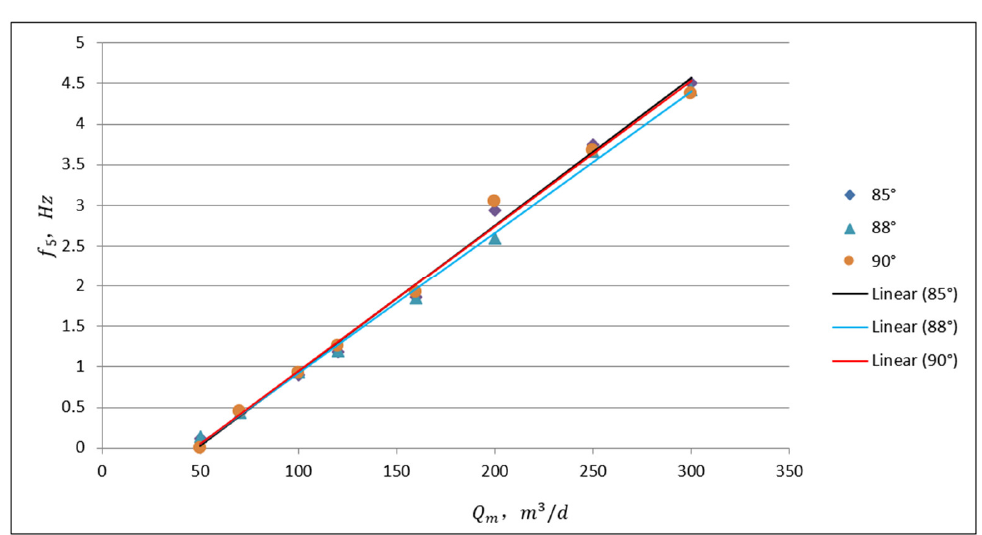
Figure 6. Single-phase (pure water) turbine response (different wellbore deviation angles, same measuring point height).